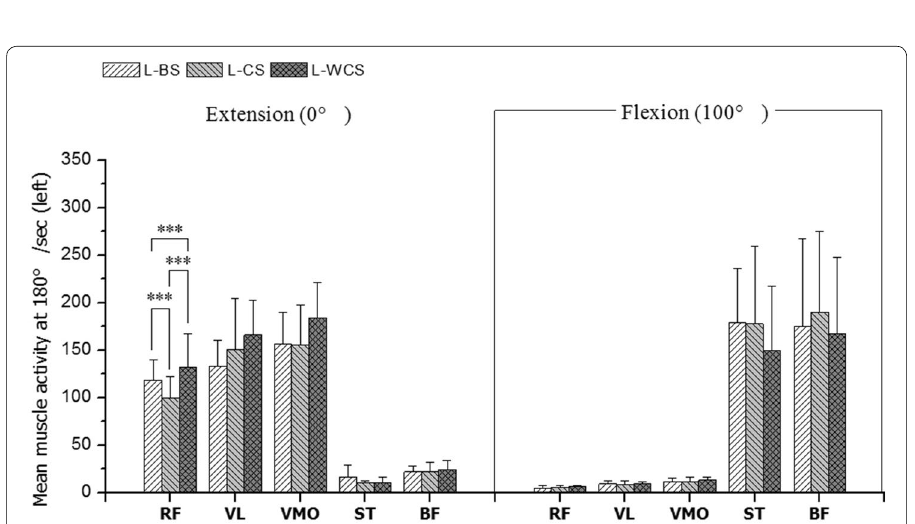
Fig. 5 Mean muscle activities of the left legs at the angular velocity of 180°/s: left (during knee extension); right (during knee